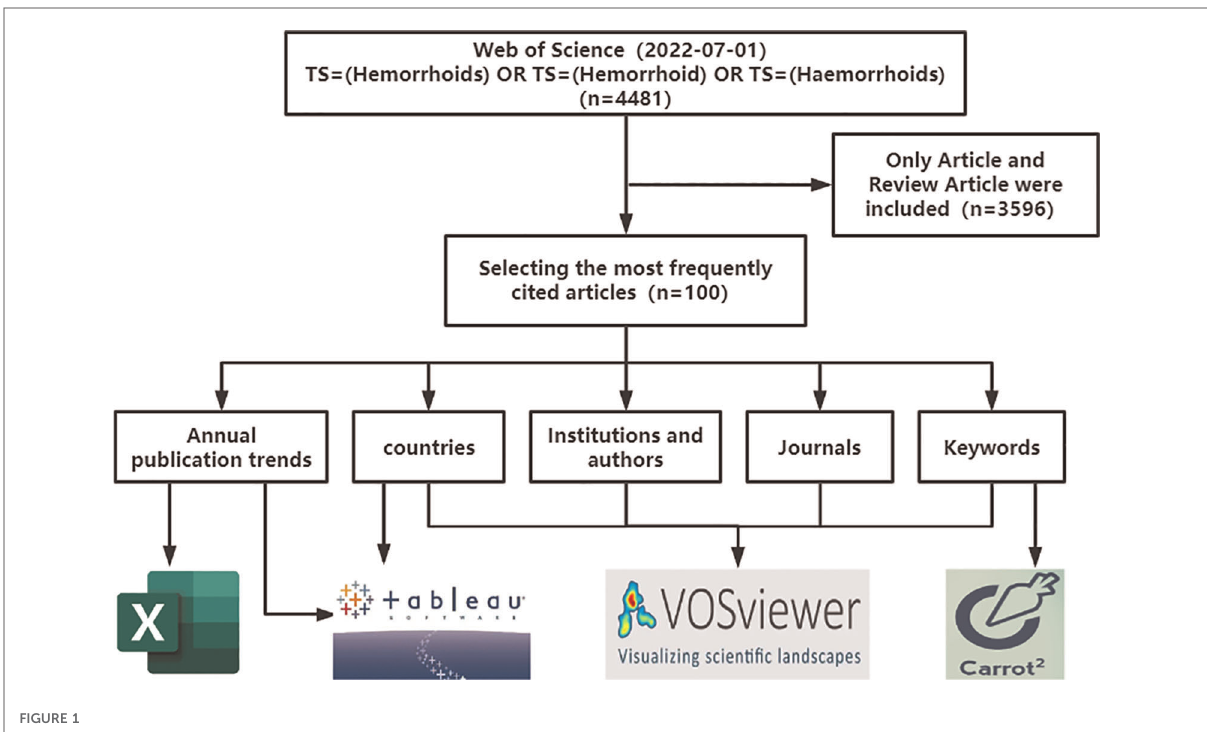
FIGURE 1 Research fl owchart.